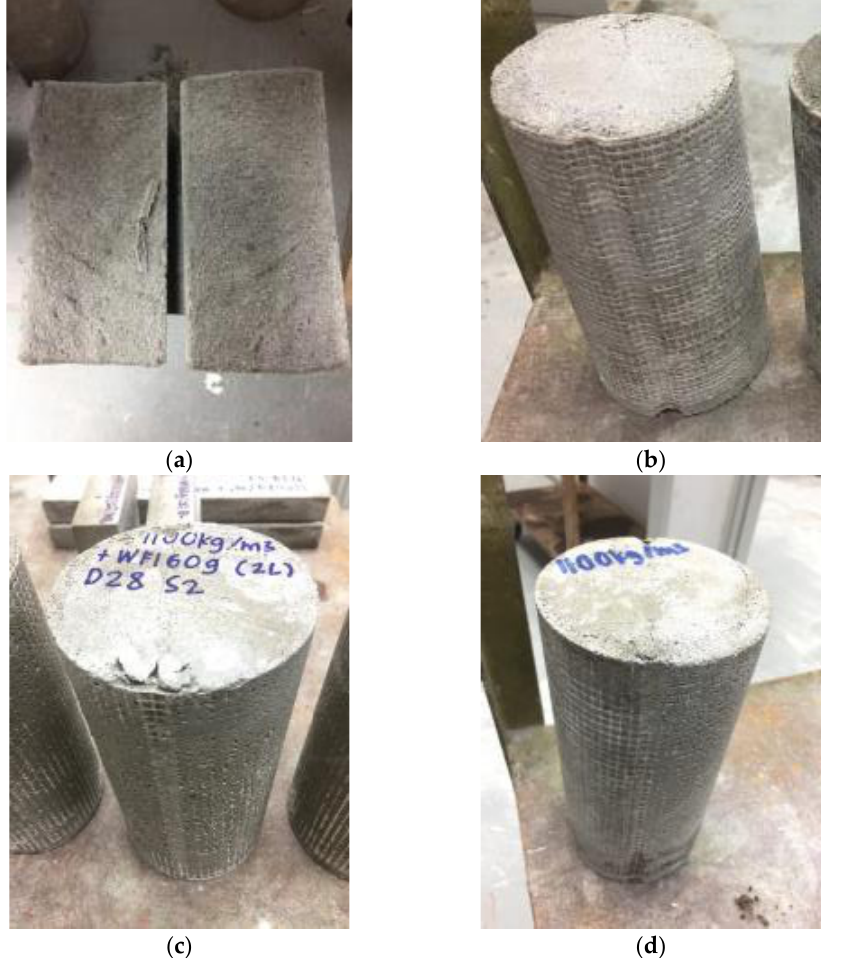
Figure 12. Failure modes of foamcrete under tension loading. ( a ) Control specimen ( b ) 1 layer of FM ( c ) 2 layers of FM ( d ) 3 layers of FM.